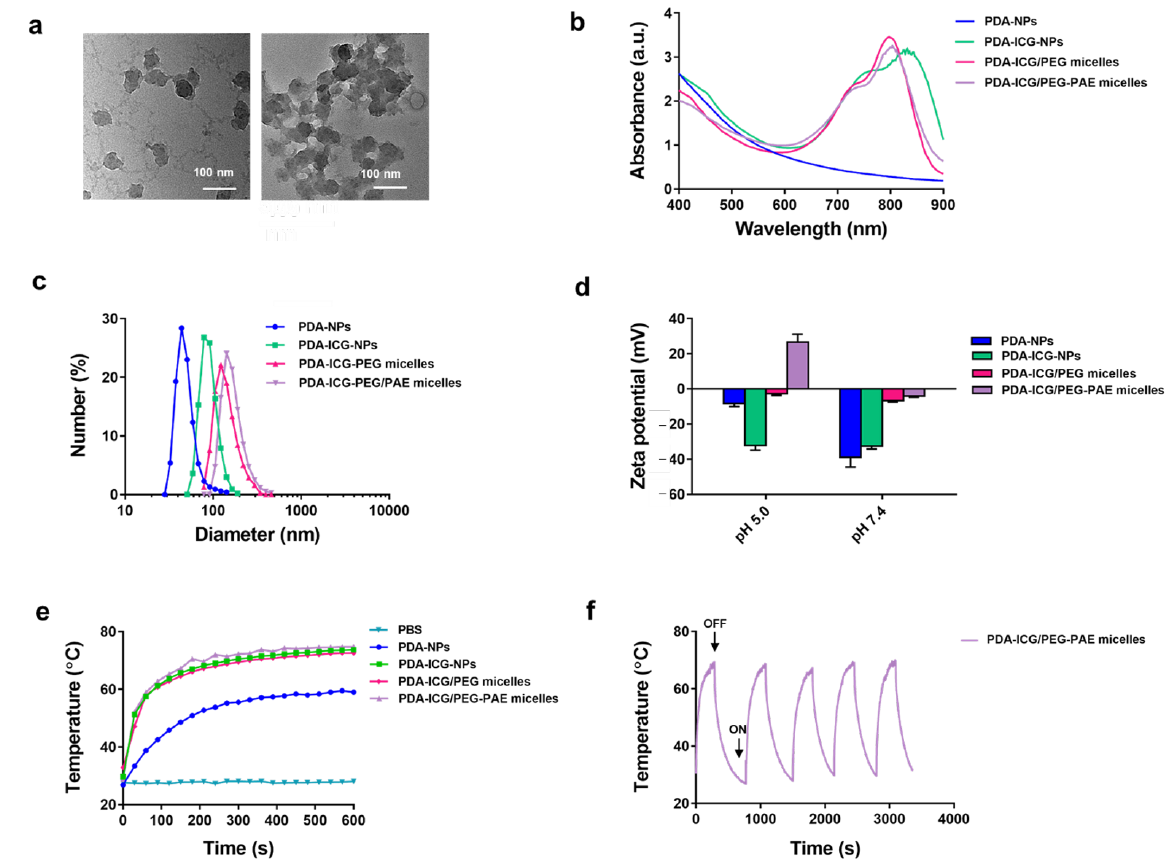
Figure 1. Characteristics, including photothermal properties, of photothermal nanoparticles before and after micellar encapsulation. ( a ) Transmission electron micrographs of PDA- and PDA-ICG-NPs. Note aggregation of hydrophobic PDA-ICG-NPs. ( b ) UV-vis absorption spectra of nanoparticles and PDA-ICG/PEG-PAE and PDA-ICG/PEG micelles (see Figure S1 for a UV-vis absorption spectrum of ICG in water). ( c ) Diameter distributions of nanoparticles before and after